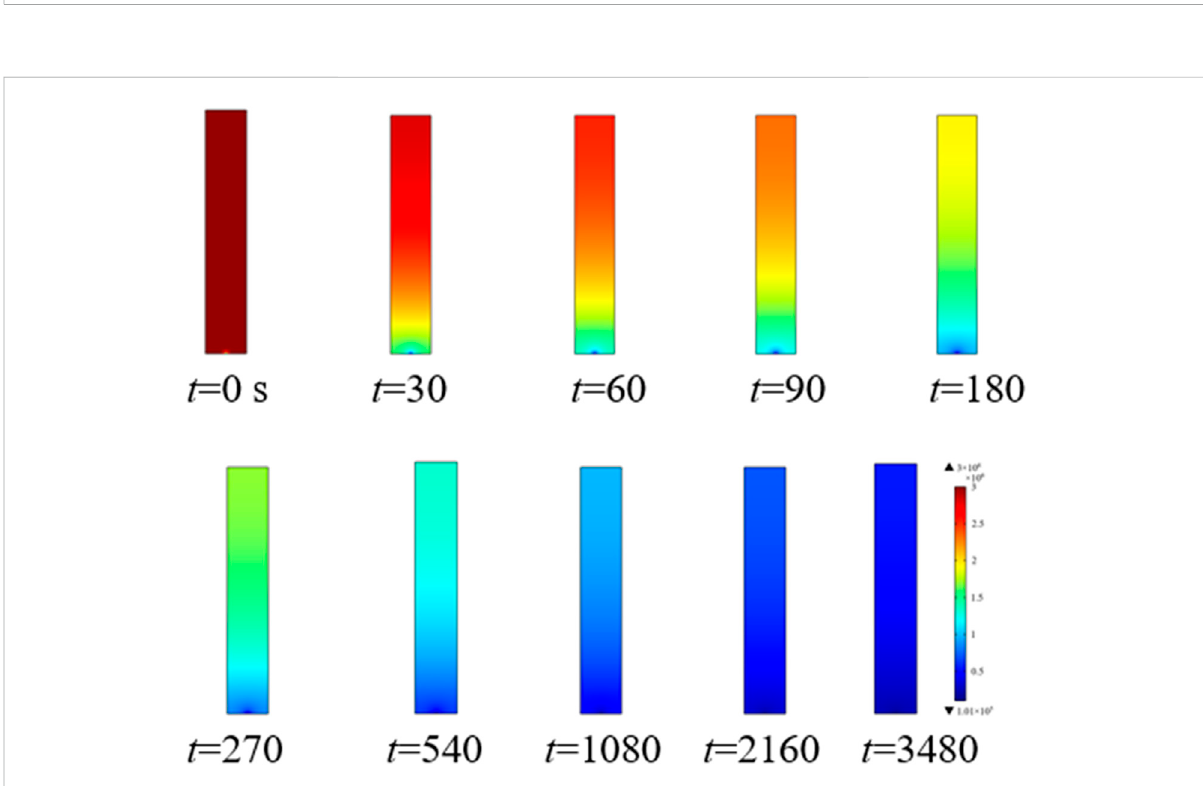
FIGURE 14 Porosity variation over time.